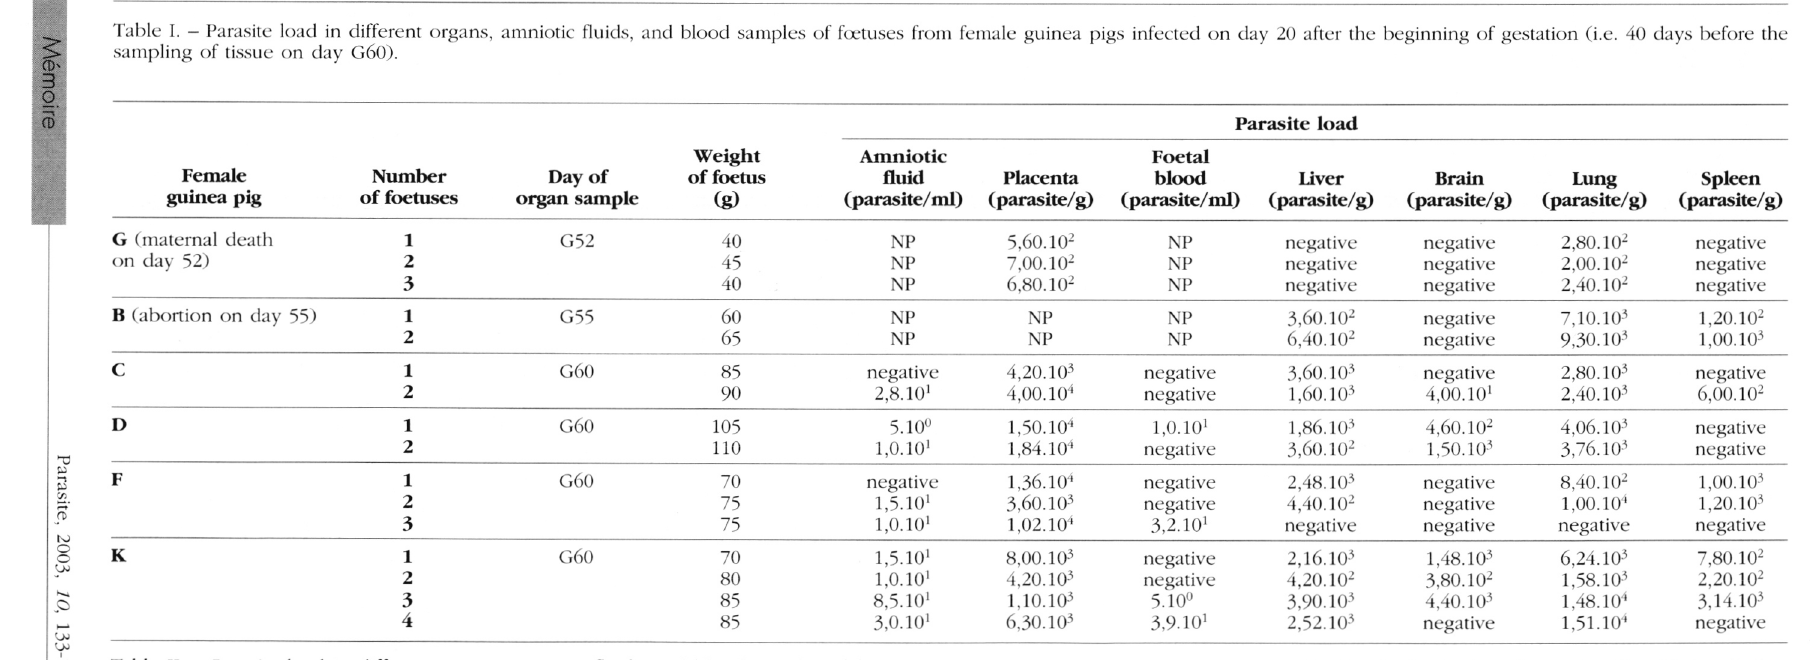
Table II. - Parasite load in different organs, amniotic fluids, and blood samples of foetuses from female guinea pigs infected on day 40 after the beginning of gestation (i.e. 20 days before the sampling of tissue on day